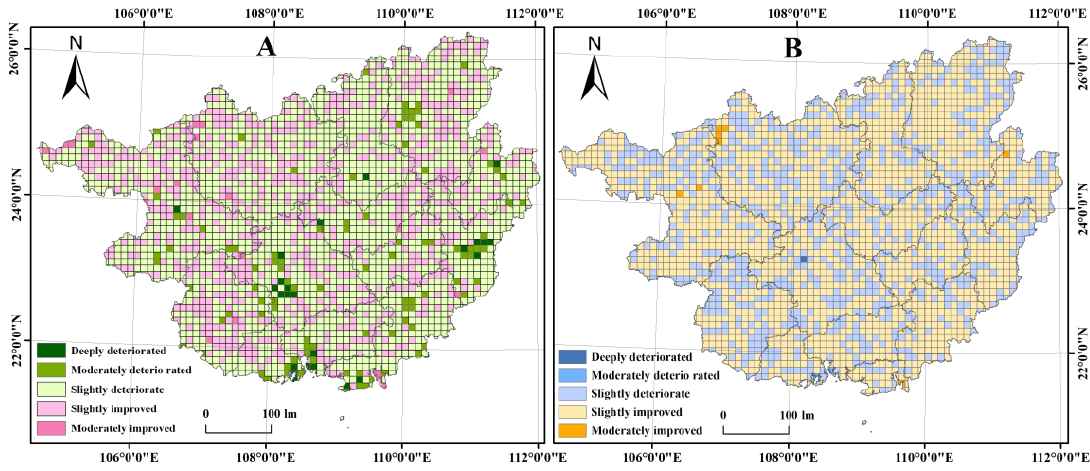
Figure 9. Map of spatial distribution of trends in ecological-economic value changes. (Note: ( A ) is ecological value, ( B ) is economic value.)